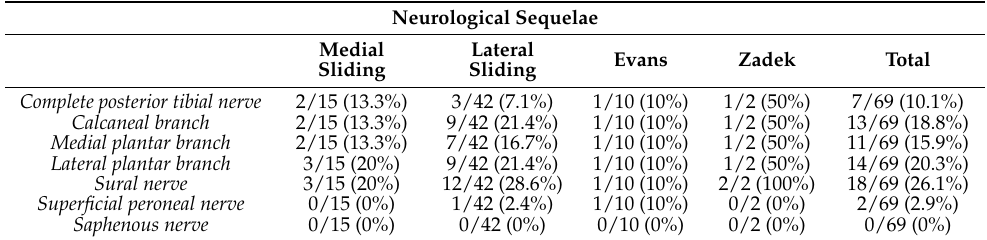
Table 3. Neurological sequelae (permanent injuries).